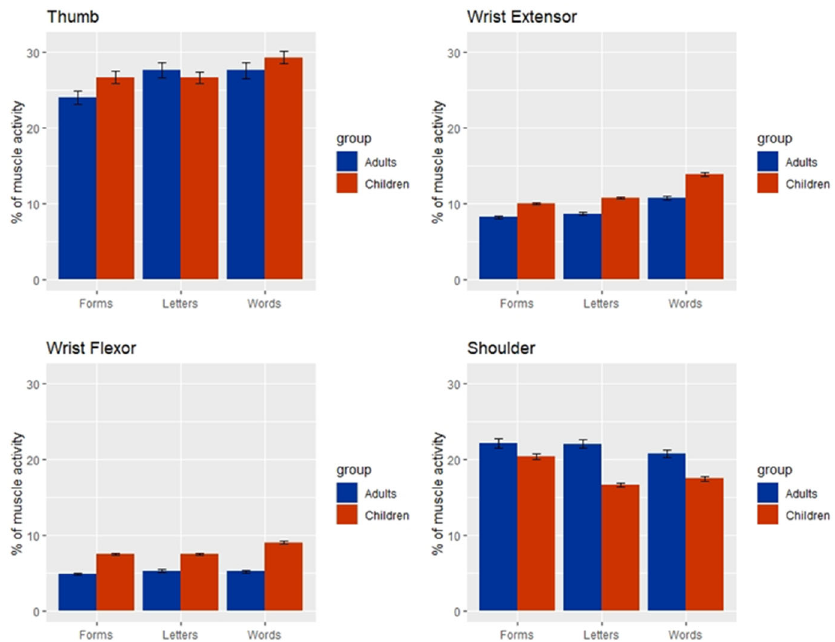
Figure 5. Mean percentage of muscle activity during handwriting tasks for each muscle, task and group (with 95% confidence intervals).